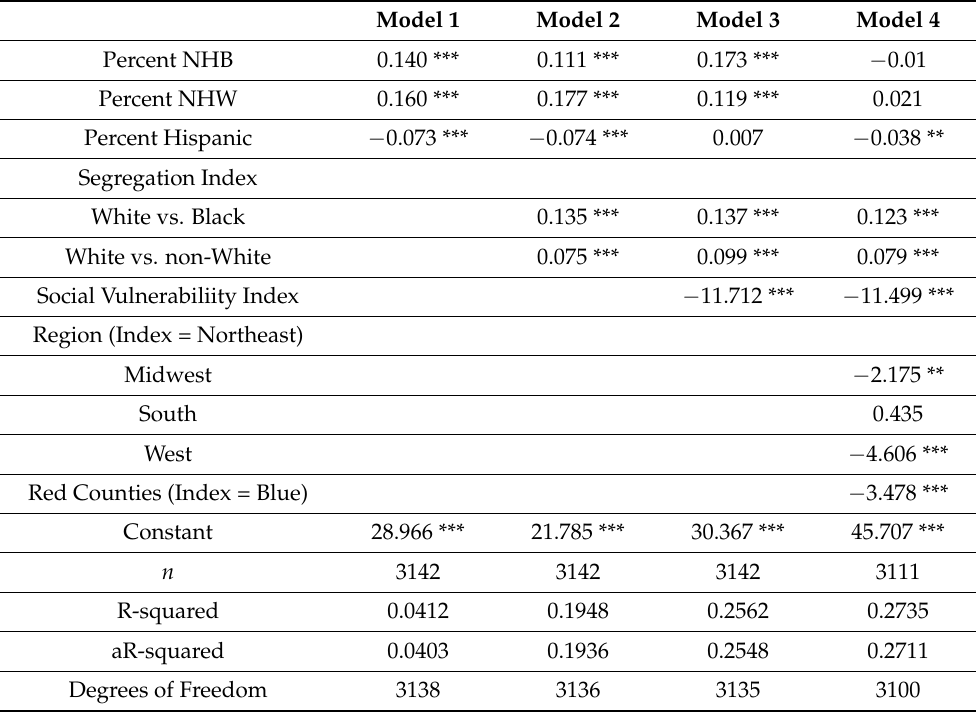
Table 3. Multiple regression models to predict county influenza vaccination